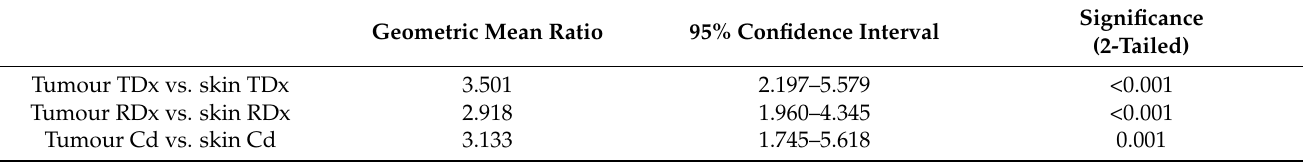
Table 1. Intratumoural docetaxel difference (for both CPC634 and conventional docetaxel) relative to the skin.